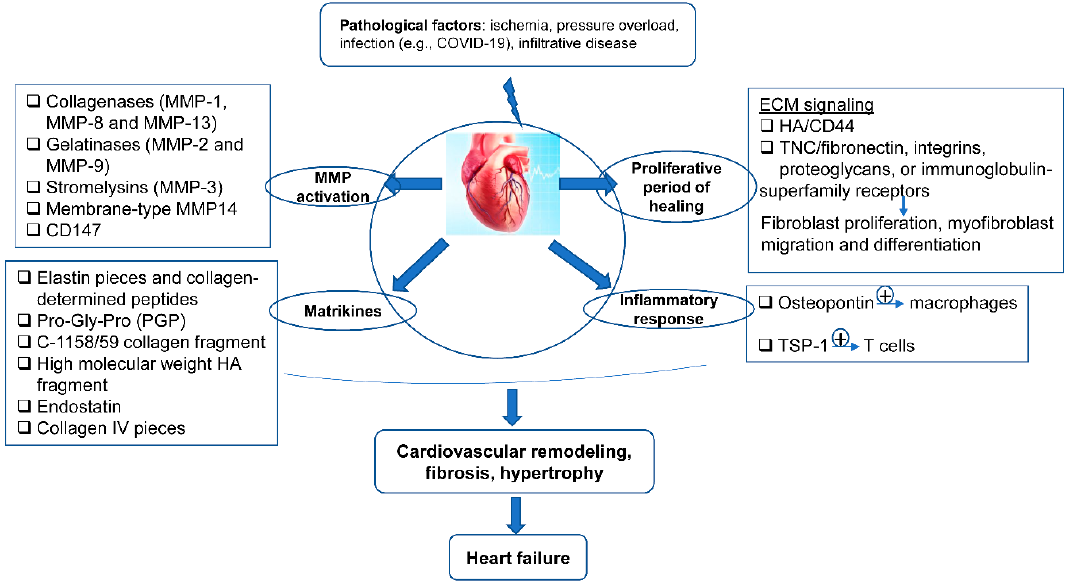
Figure 2. The ECM in the programming of cardiovascular repair and disease. Cardiovascular pathological factors induce abnormal synthesis and release of ECM proteins and ECM signaling, implicated in the process of matrix metalloproteinase (MMP) activation, matrikines production, proliferation, and inflammatory response; this results in cardiovascular remodeling, fibrosis, hypertrophy, and thus heart